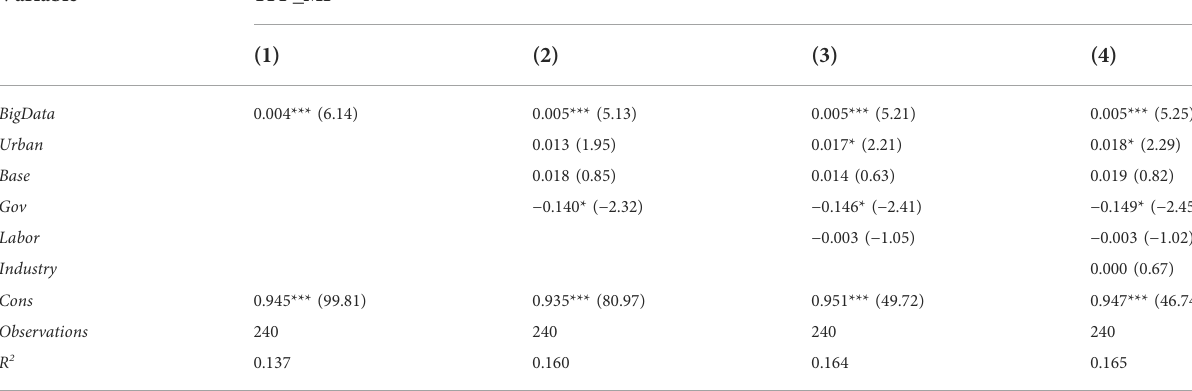
TABLE 2 Empirical results of big Data ’ s impact on green economic development.